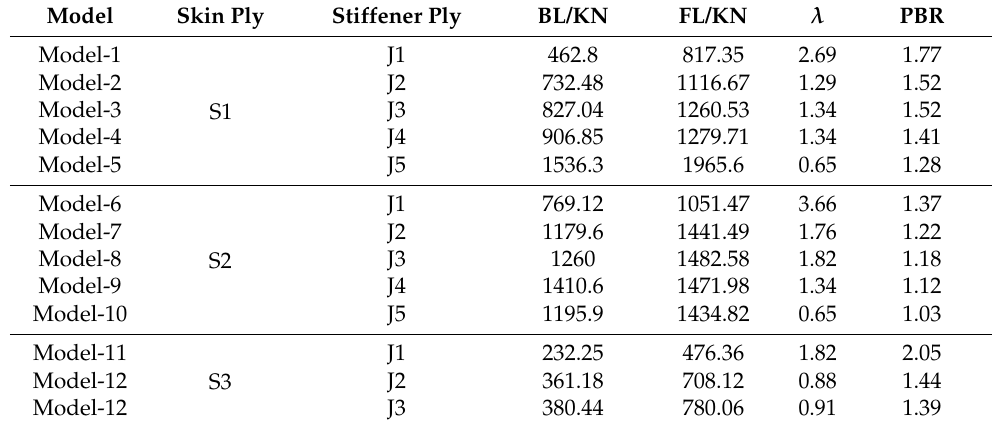
Table 9. Post-buckling ratio and skin/stringer stiffness ratio of simulation matrix.